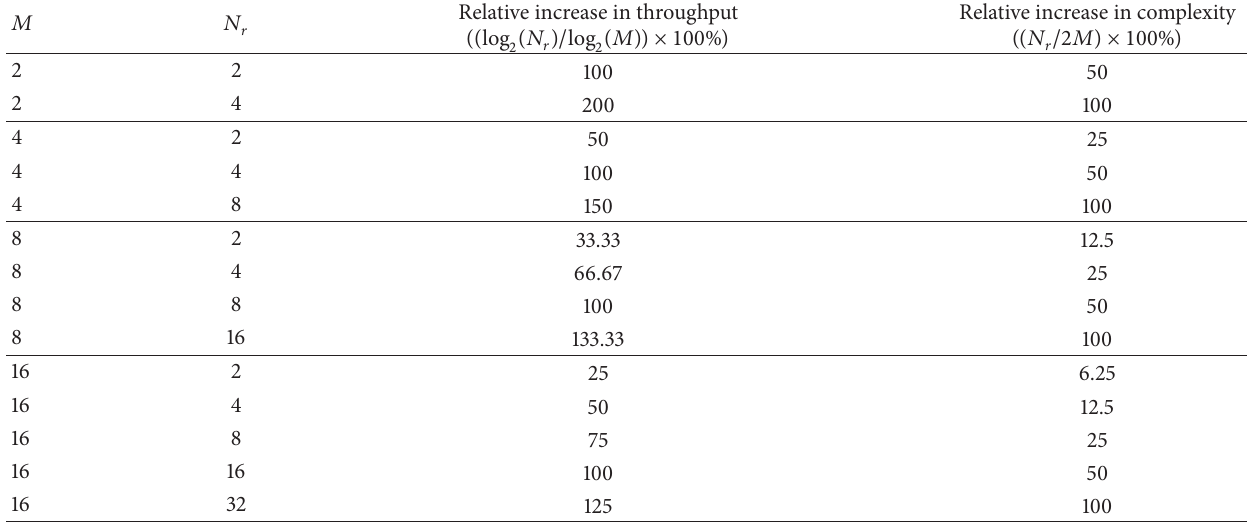
Table 1: The increase in throughput and complexity of MU-SM relative to those of conventional MU-MIMO.